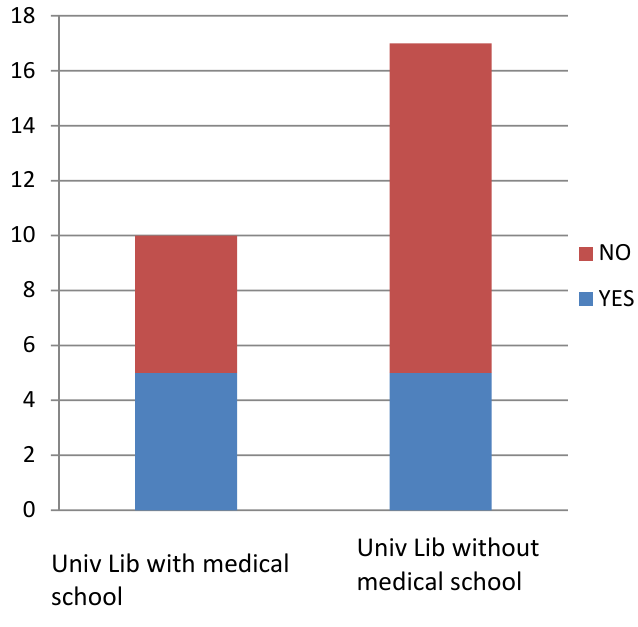
Figure 8. Membership in an OA providers’ organization.